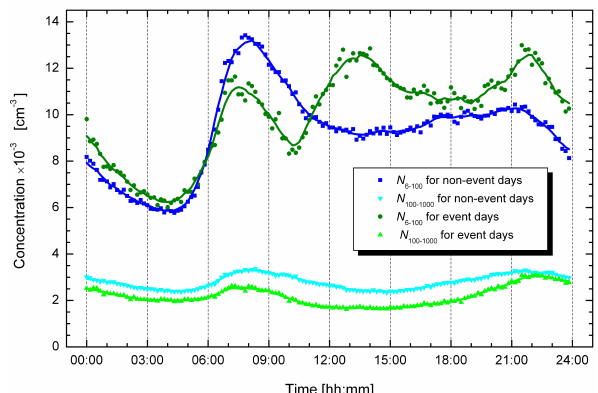
Fig. 3. Diurnal variation of the mean number concentration for par- ticles in diameter intervals of 6–100nm and 100–1000nm, averaged by the time of day separately for the days with new particle forma- tion event and without new particle formation event. The curves were obtained by 1-h smoothing and represent an eye-guide